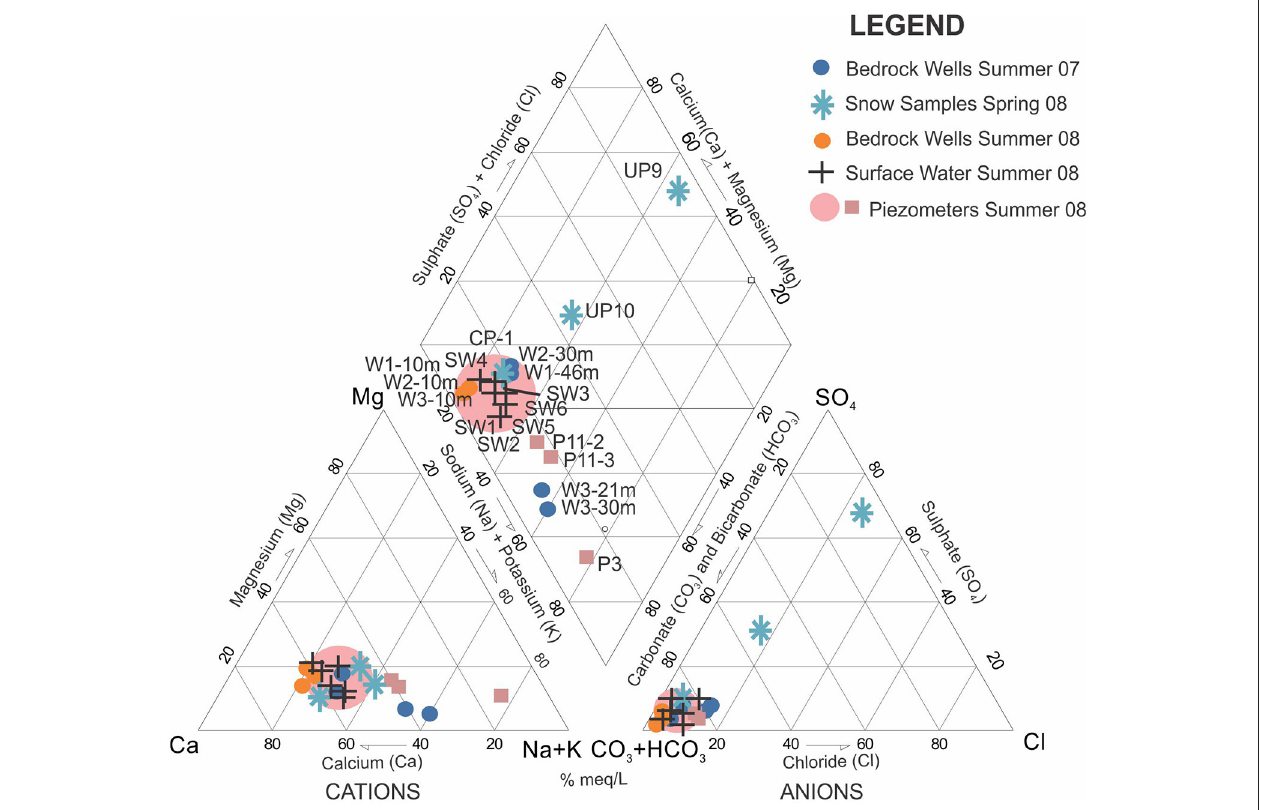
FIGURE 8 | Piper plot showing major ion chemistry for waters sampled in the UPC241 catchment in 2007 and 2008. The locations of sampling points are shown in Figure 2 .